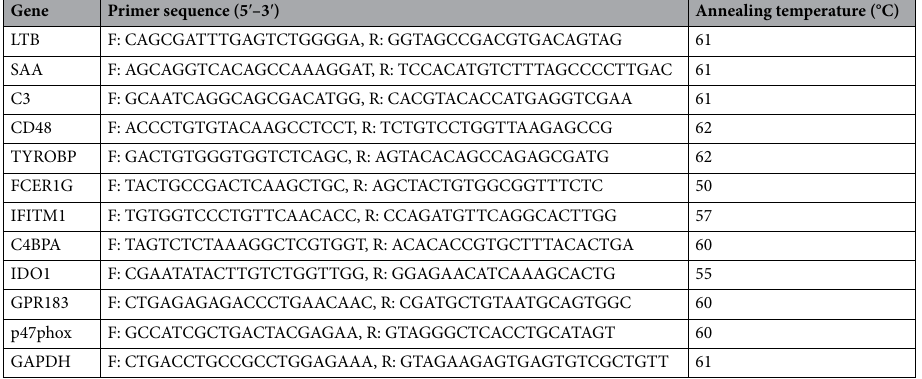
Table 5. The primers of genes in RT-qPCR